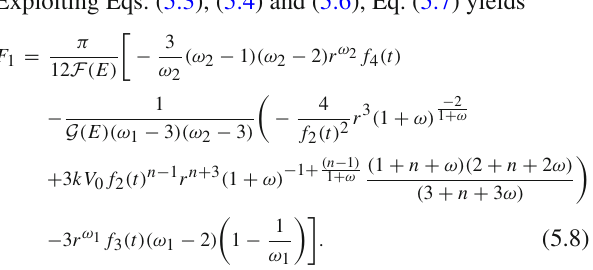
Fig.6 Showthevariationofthemetricfunction f ( t , r ) against r fordif- ferent values of the equation of state parameter k in Brans–Dicke grav- ity’s rainbow. In a the other parameters are fixed at α = 0 . 1 ,β = 0 . 2,